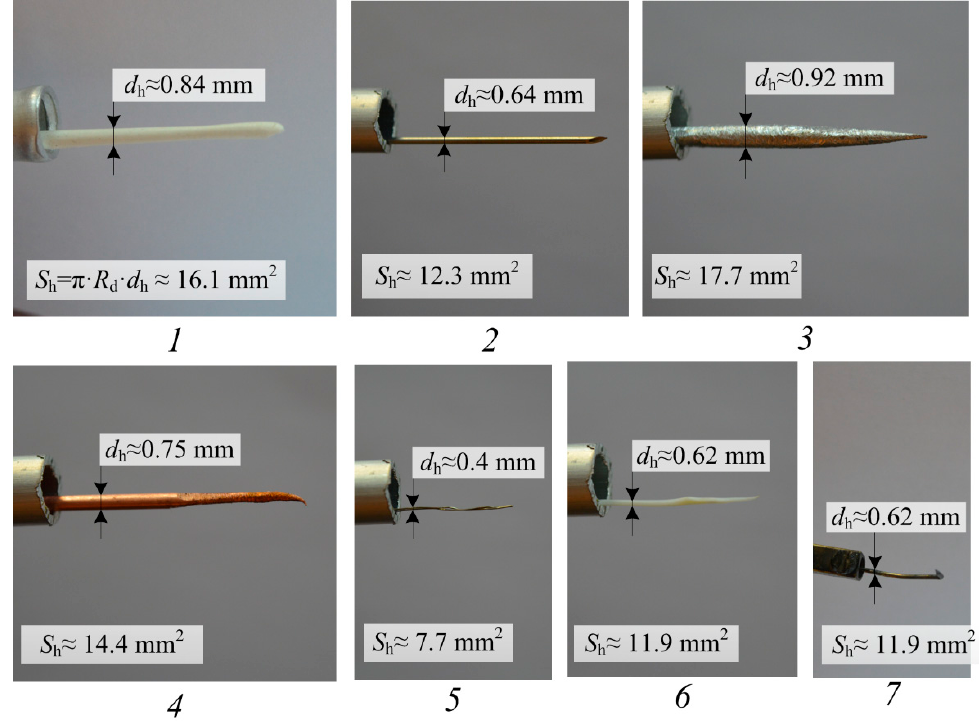
Figure 1. Appearance of holders used in the experiments (their size and contact area with a